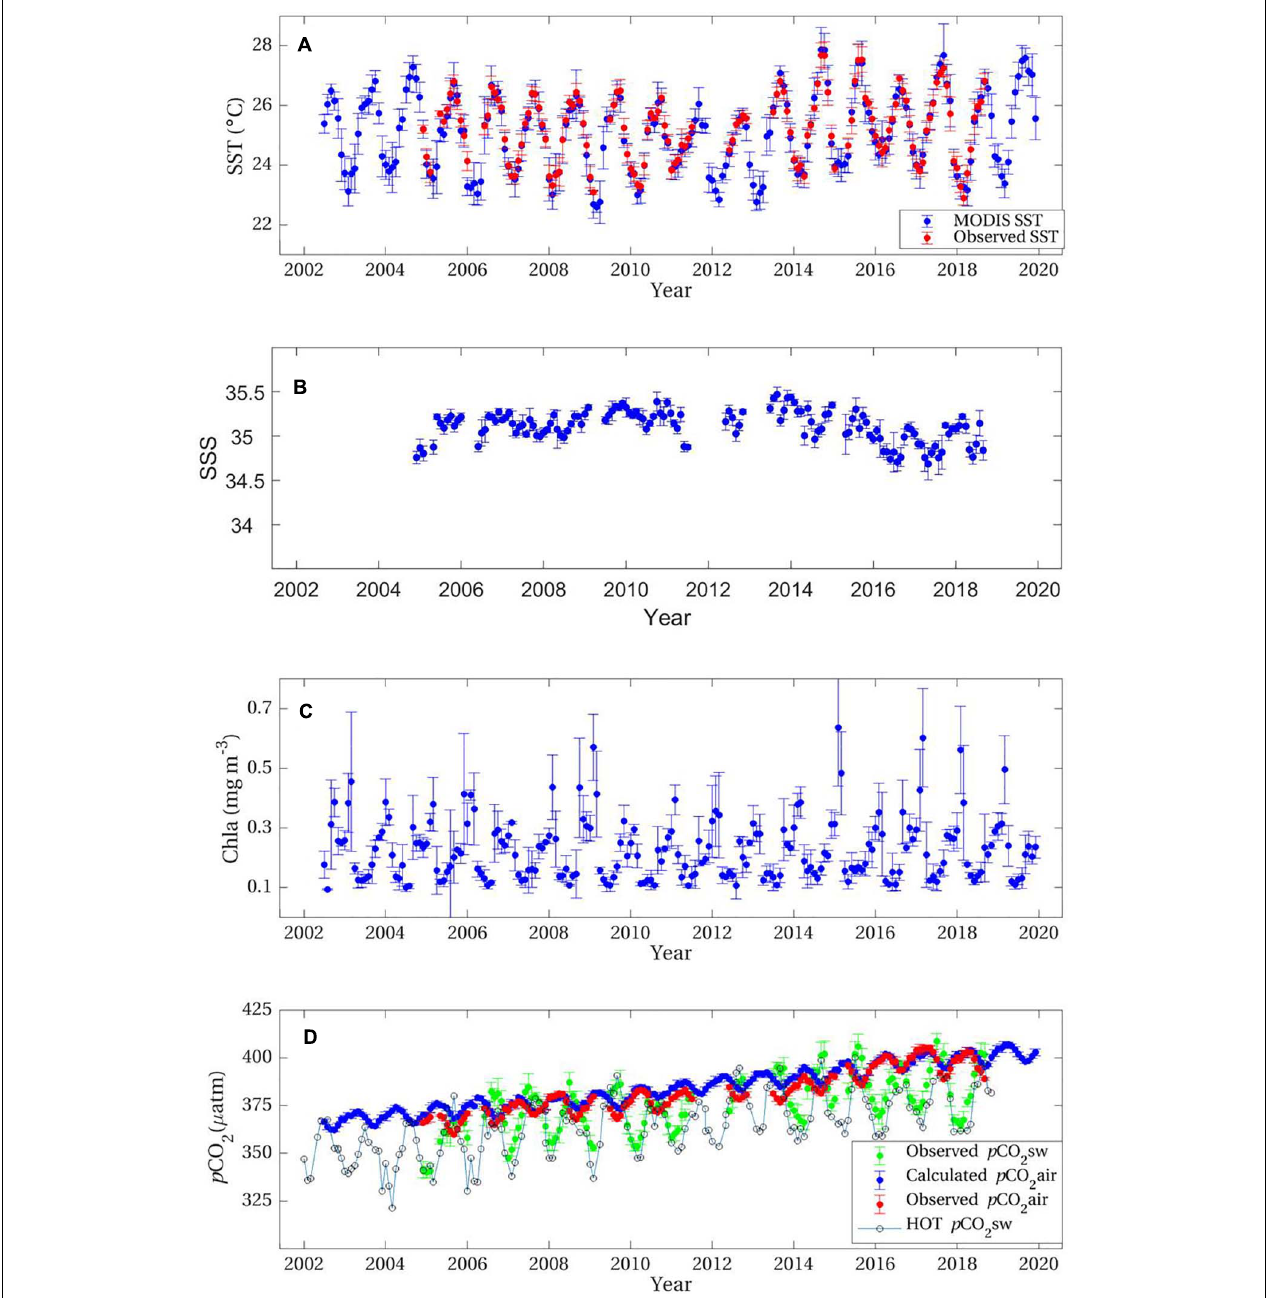
FIGURE 2 | Interannual variations of the monthly SST (A) , SSS (B) , Chla (C) , p CO 2 air, and p CO 2 sw (D) at the WHOTS station in the period of 2002–2019. Note that the ship-based monthly p CO 2 sw time series at HOT calculated from DIC and TA measurements was overlaid in (D) for reference, and the calculated p CO 2 air in (D) is based on the data of atmospheric CO 2 measured at